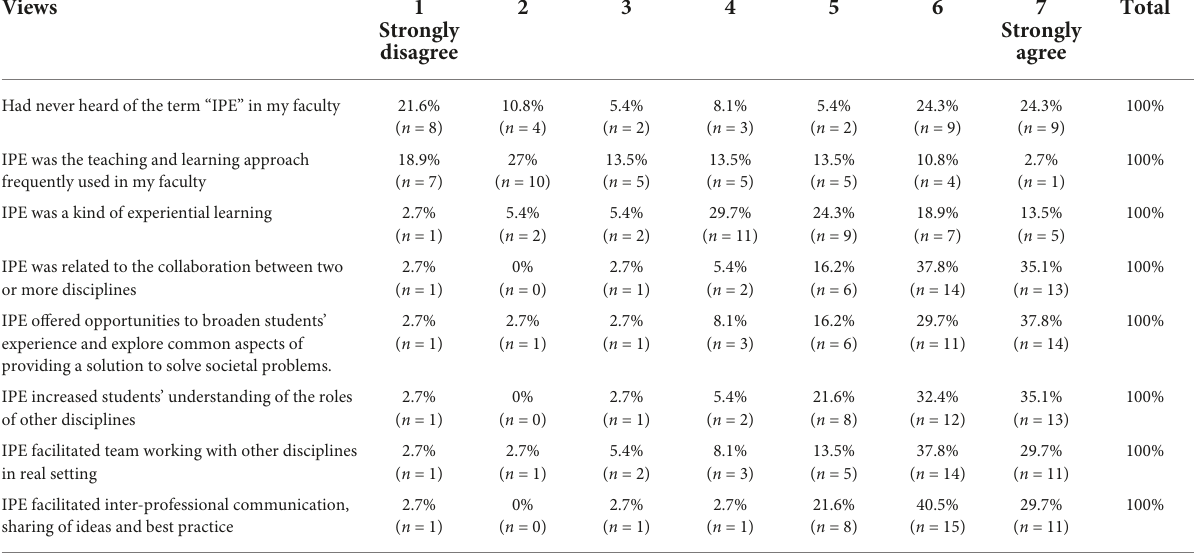
TABLE 2 Understanding and perception of interprofessional education